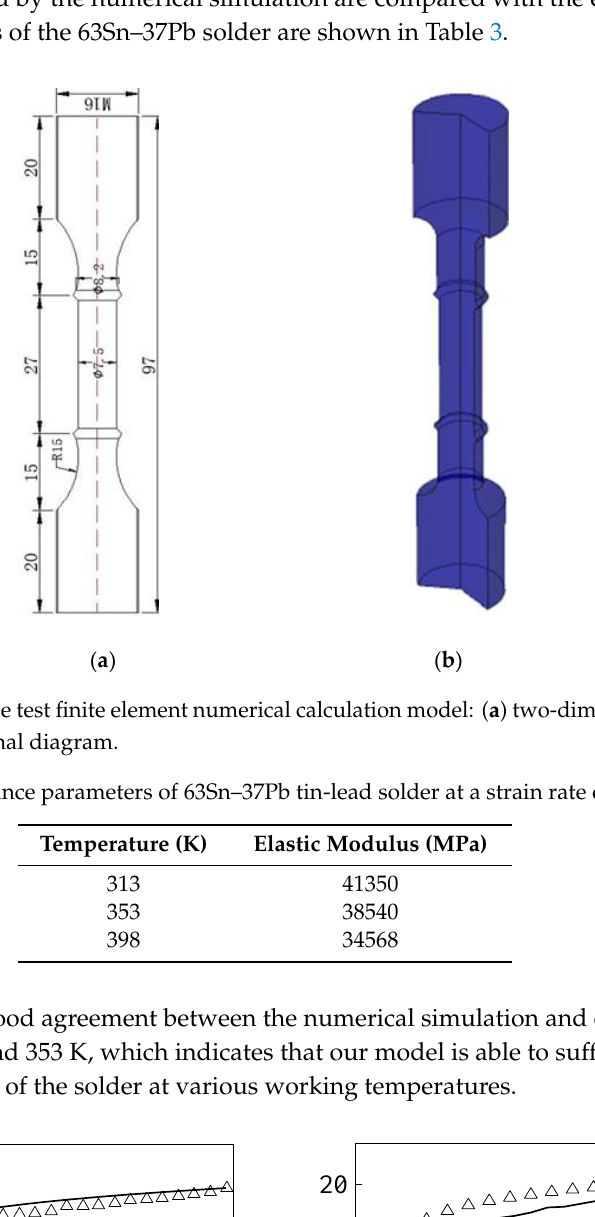
Table 3. Performance parameters of 63Sn–37Pb tin-lead solder at a strain rate of 0.5% s −1 .